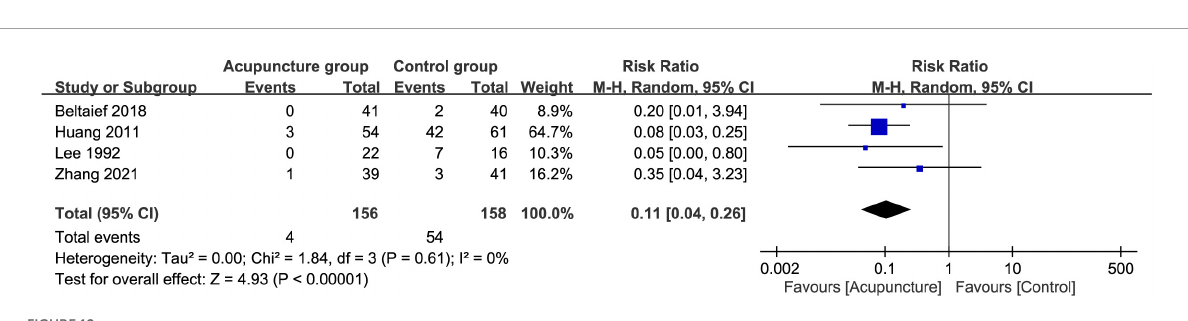
FIGURE12 Forest plot comparing the overall risk of side effects between acupuncture and control groups. CI, confidence interval; RR, risk ratio; M-H,